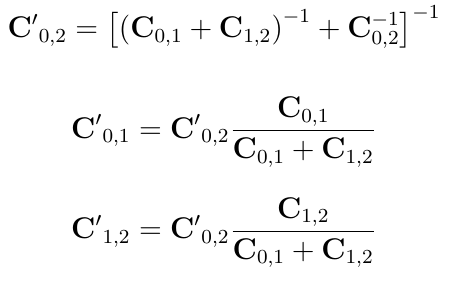
Figure 10. Example showing the merging of the covariances of edges. ( a ) Before merging C to C and C ; ( b ) After merging, C (cid:48) 0 , 2 0 , 1 1 , 2